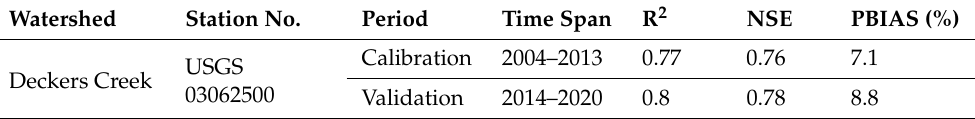
Table 4. Goodness-of-fit statistics for the monthly streamflow at the US Geological Survey